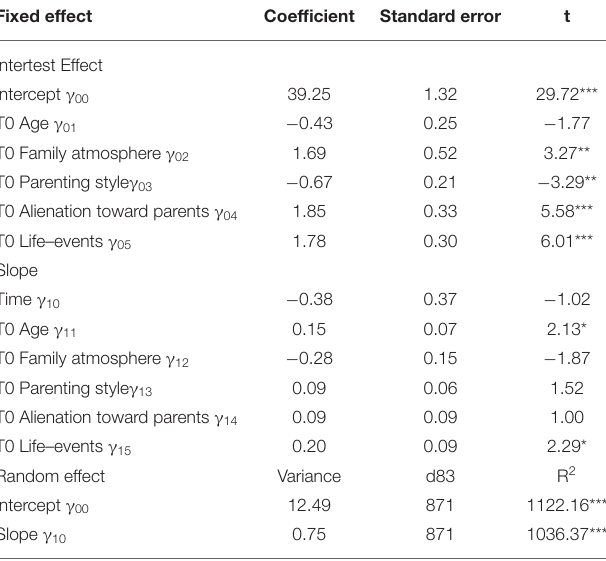
TABLE 4 | Estimated results of the full